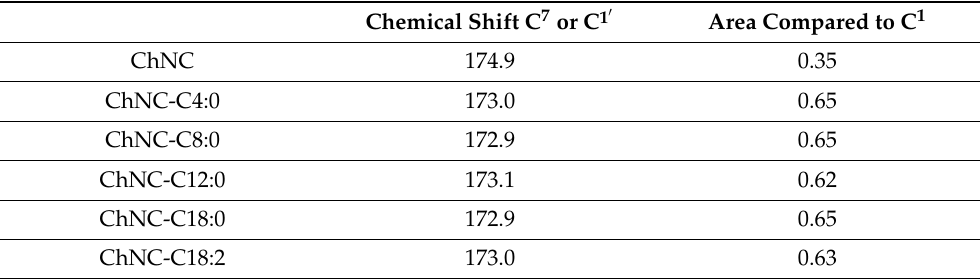
Table 1. The 13 C NMR chemical shift of C 7 for unmodified ChNC and C 1 ′ for modified ChNC, in- cluding the peak area compared to C 1 .